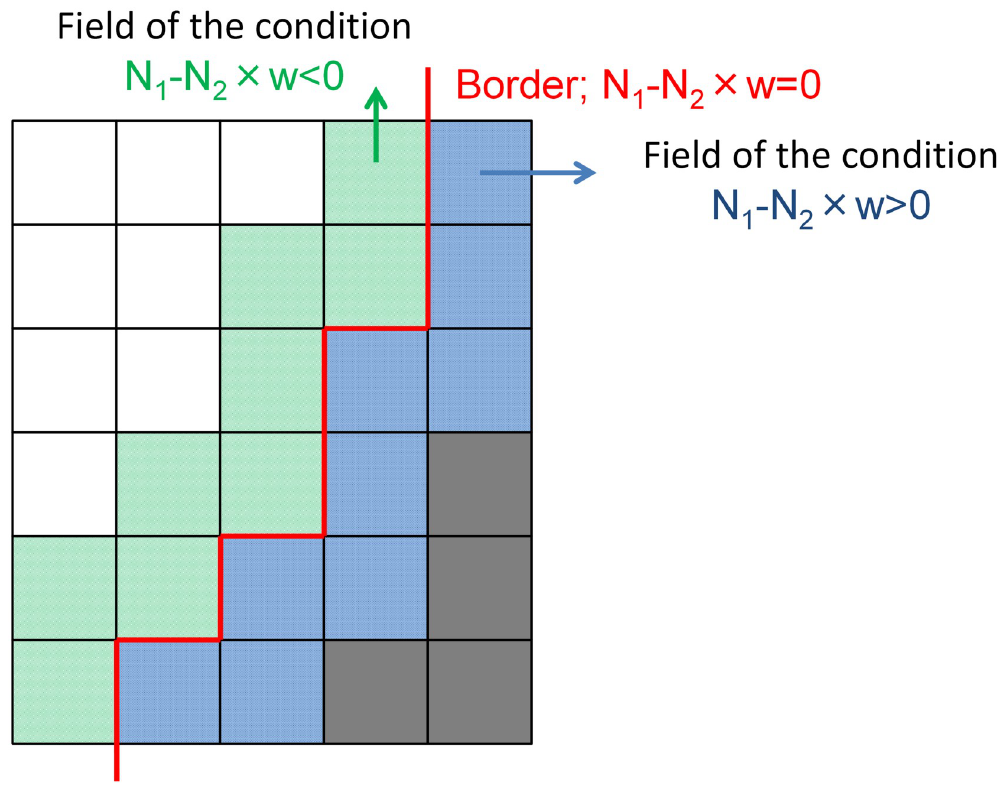
Fig 5. An example of the boundary between black cells (state 1) and white cells (state 0). In the convolution calculation with the filter on the black cells (1) in contact with the white cells (0), the value of N 1 − N 2 w is > 0. In the same calculation on the white cells (0) in contact with black cells (1), the value of N 1 − N 2 w is < 0.